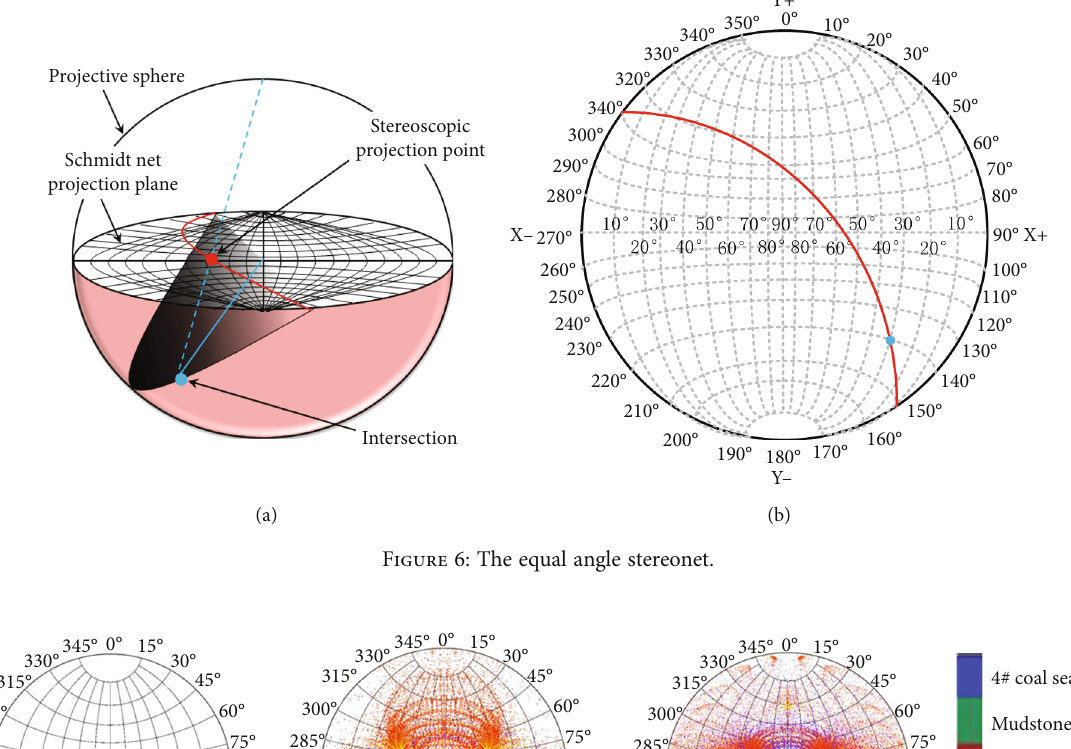
Figure 6: The equal angle stereonet.